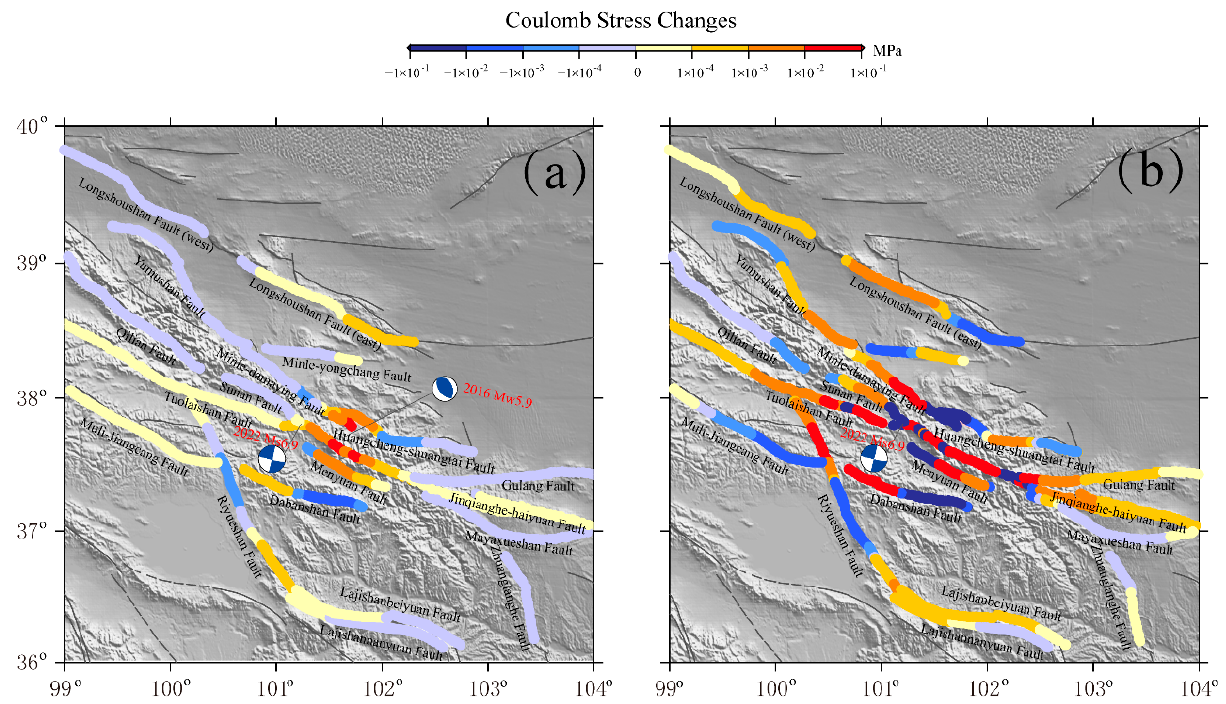
Figure 11. Coulomb stress changes caused by the 2016 and 2022 Menyuan earthquakes. ( a ) Co- and post-seismic Coulomb stress changes for the 2016 Mw 5.9 earthquake and ( b ) coseismic Coulomb stress changes for the 2022 Ms 6.9 earthquake.